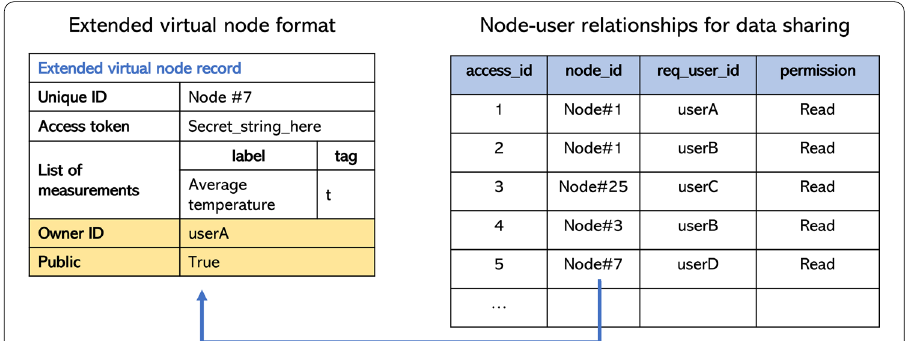
Fig. 4 Data sharing semantic with extended virtual node format and relationship